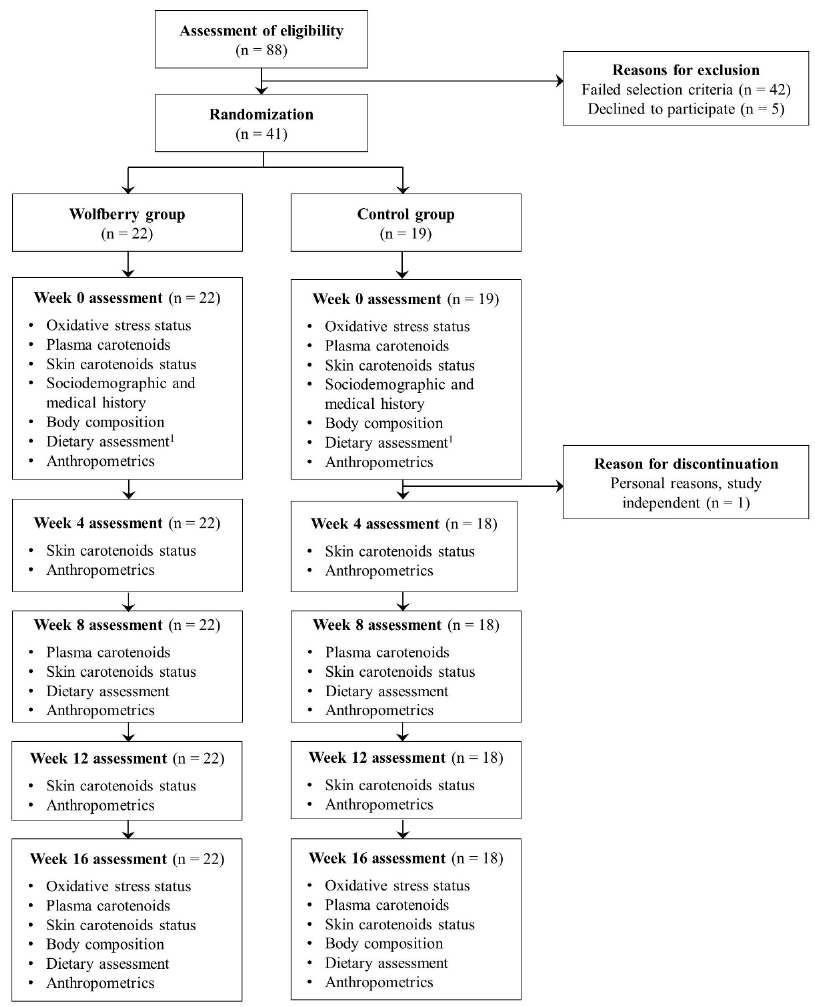
Figure 1. Consolidated Standards of Reporting Trials (CONSORT) flow diagram for randomized controlled trial 2 . 1 Dietary assessment was absent for one participant from each group at week 0. 2 The wolfberry group received dietary counselling to adhere to a healthy dietary pattern and consumed 15 g/d whole while the control group received dietary counselling to adhere to a healthy dietary pattern only.